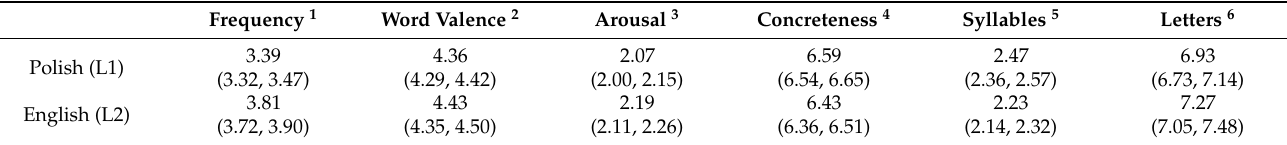
Table 3. The lexico-semantic properties of the critical words (means with 95%